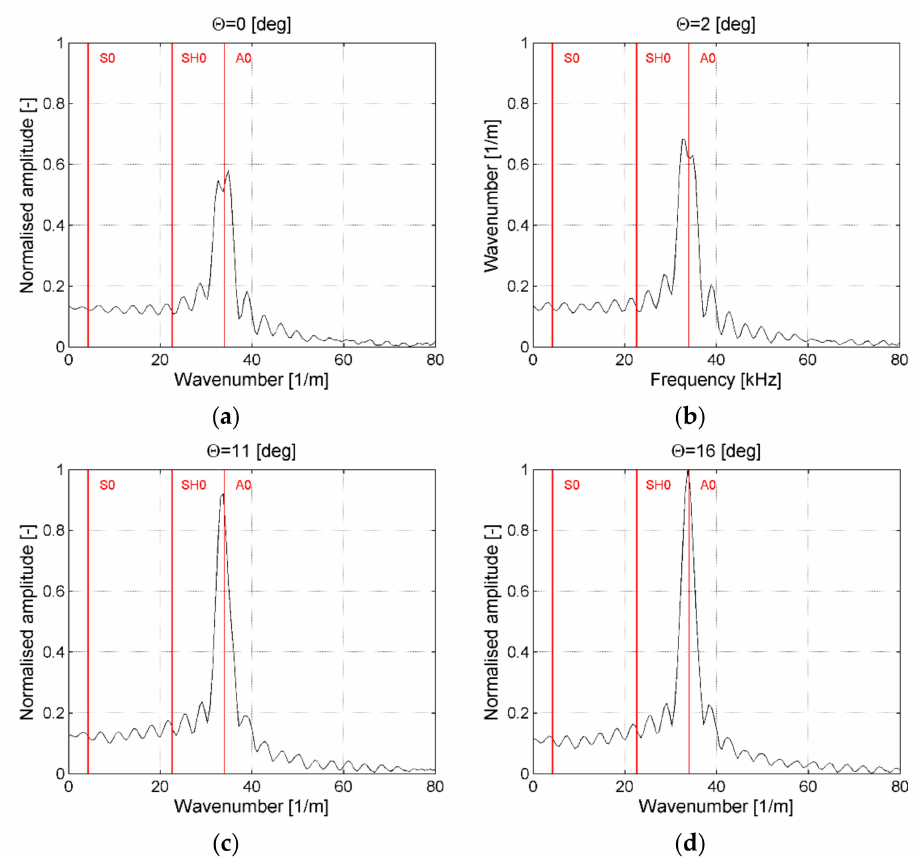
Figure 11. Amplitude–wavenumber plots for ACT incidence angle θ equal: ( a ) 0 ◦ , ( b ) 2 ◦ , ( c ) 11 ◦ , ( d ) 16 ◦ ; waves generation along reinforcing